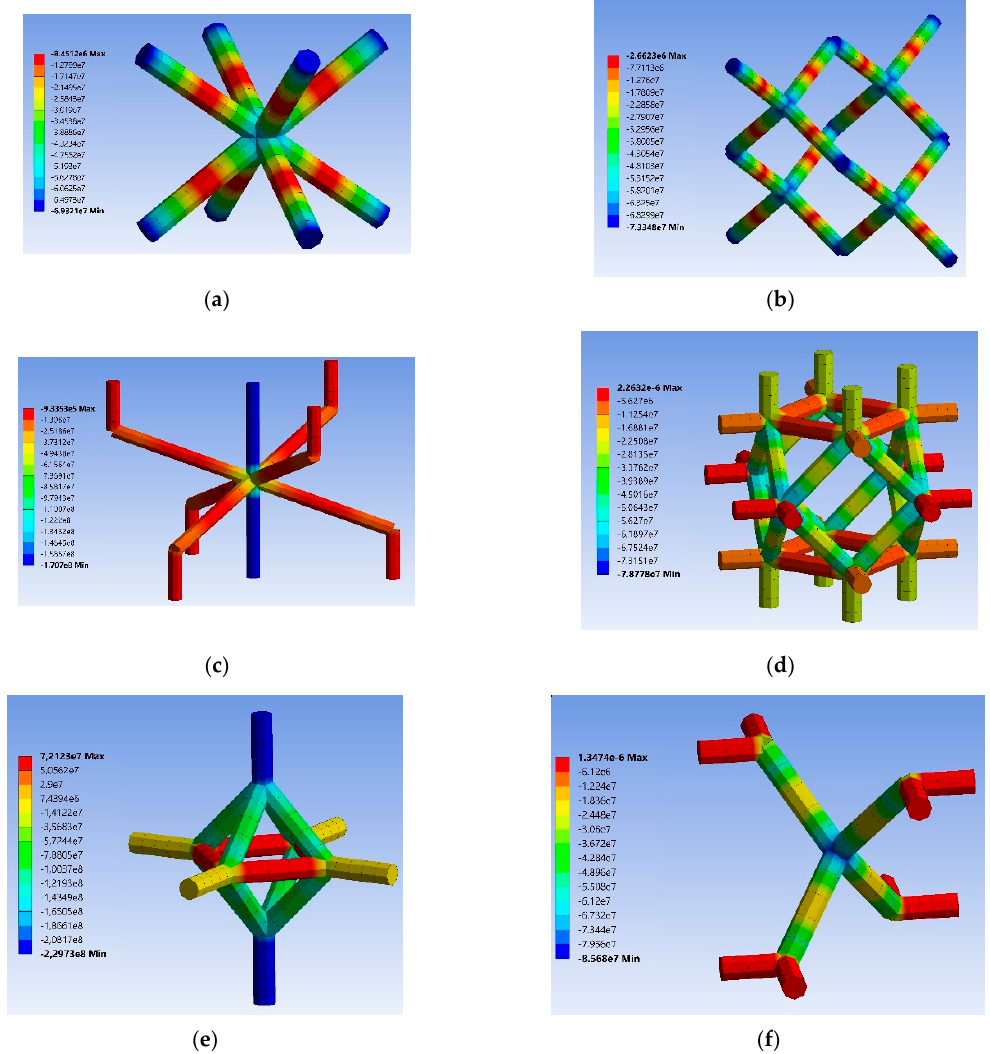
Figure A4. Bending stress of unit cells: ( a ) BCC; ( b ) diamond; ( c ) hexagonal packing; ( d ) rhombicuboctahedron; ( e ) trun- cated cube; and ( f ) truncated octahedron in ANSYS.